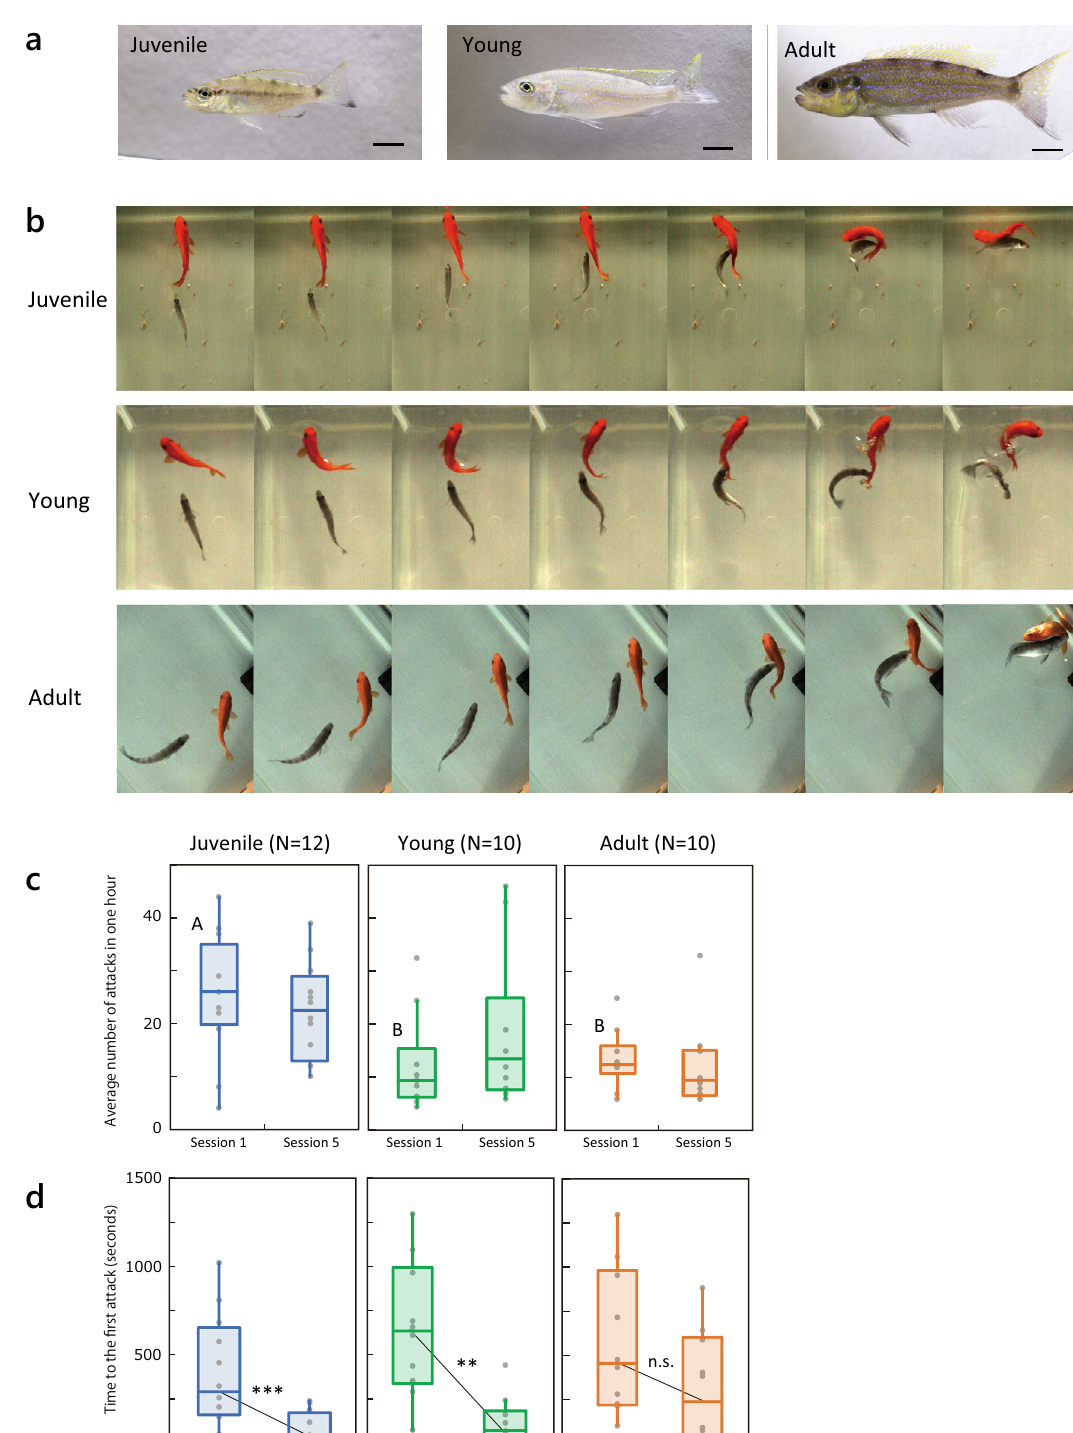
Figure 1. Scale-eating in naïve Perissodus microlepis . ( a ) Lateral view of juvenile (4 months old), young (8 months old), and adult (12 months old) cichlids reared in a tank without scale-eating experience. Bar: 1 cm. ( b ) Series of predation behaviors of three naïve lefty P. microlepis (gray) at different ages (Juvenile, Young, and Adult) in the first test session (Session 1). The predators are shown encountering prey goldfish (red) for the first time in their lifetime. ( c ) Number of attacks in 1 h during Sessions 1 and 5 at three stages of development (juvenile, N = 12; young, N = 10; adult, N = 10). “A” and “B” above the boxplots represent significant differences in pairwise comparisons (Tukey HSD test , p < 0.05). ( d ) Time to first attack by the predators after the introduction of prey fish into the tank. Wilcoxon signed-rank test was used to compare the time to initial attack in Sessions 1 and 5. ** p < 0.01; *** p < 0.001. n.s., not